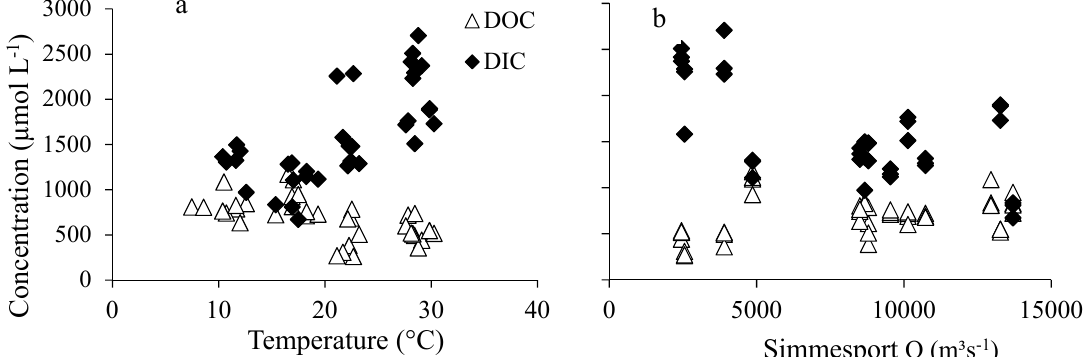
Figure 5. ( a ) Relationships between DOC concentration and water temperature (y = − 18.9x + 1061.9, p < 0.0001, R 2 = 0.34) and DIC concentration and recorded water temperature (y = 56.0x + 377.7, p < 0.0001, R 2 = 0.45); ( b ) Relationships between DOC concentration and discharge at Simmesport (y = 0.02x + 478.7, p = 0.01, R 2 = 0.17) and DIC concentration and discharge at Simmesport (y = − 0.09x + 2293.7, p < 0.0001, R 2 = 0.41).